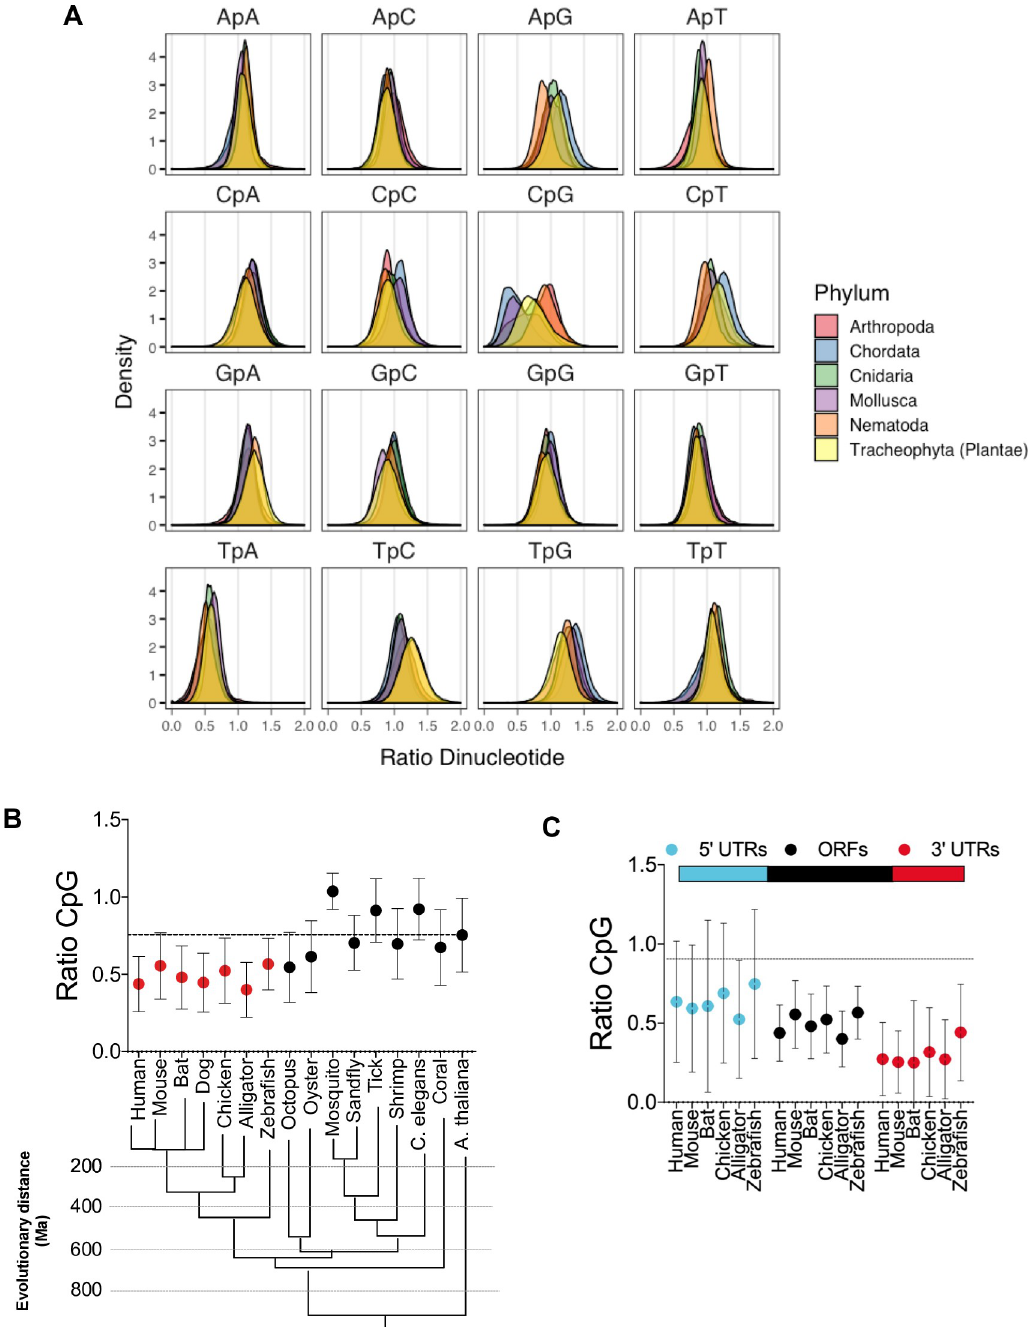
Fig 3. RNA transcripts from vertebrates are CpG-suppressed. (A) Open reading frames (ORFs) from several organisms belonging to the indicated phyla were collected from the NCBI nucleotide database and dinucleotide frequency ratio (observed/ expected) was calculated and frequency distribution for each dinucleotide in ORFs was plotted. (B) Average dinucleotide observed/expected ratio in various animal species. Evolutionary distance (presented in million years, Ma) of indicated species was based on [36]. (C) Average dinucleotide observed/expected ratio in various portions of vertebrate mRNA transcripts vertebrates.